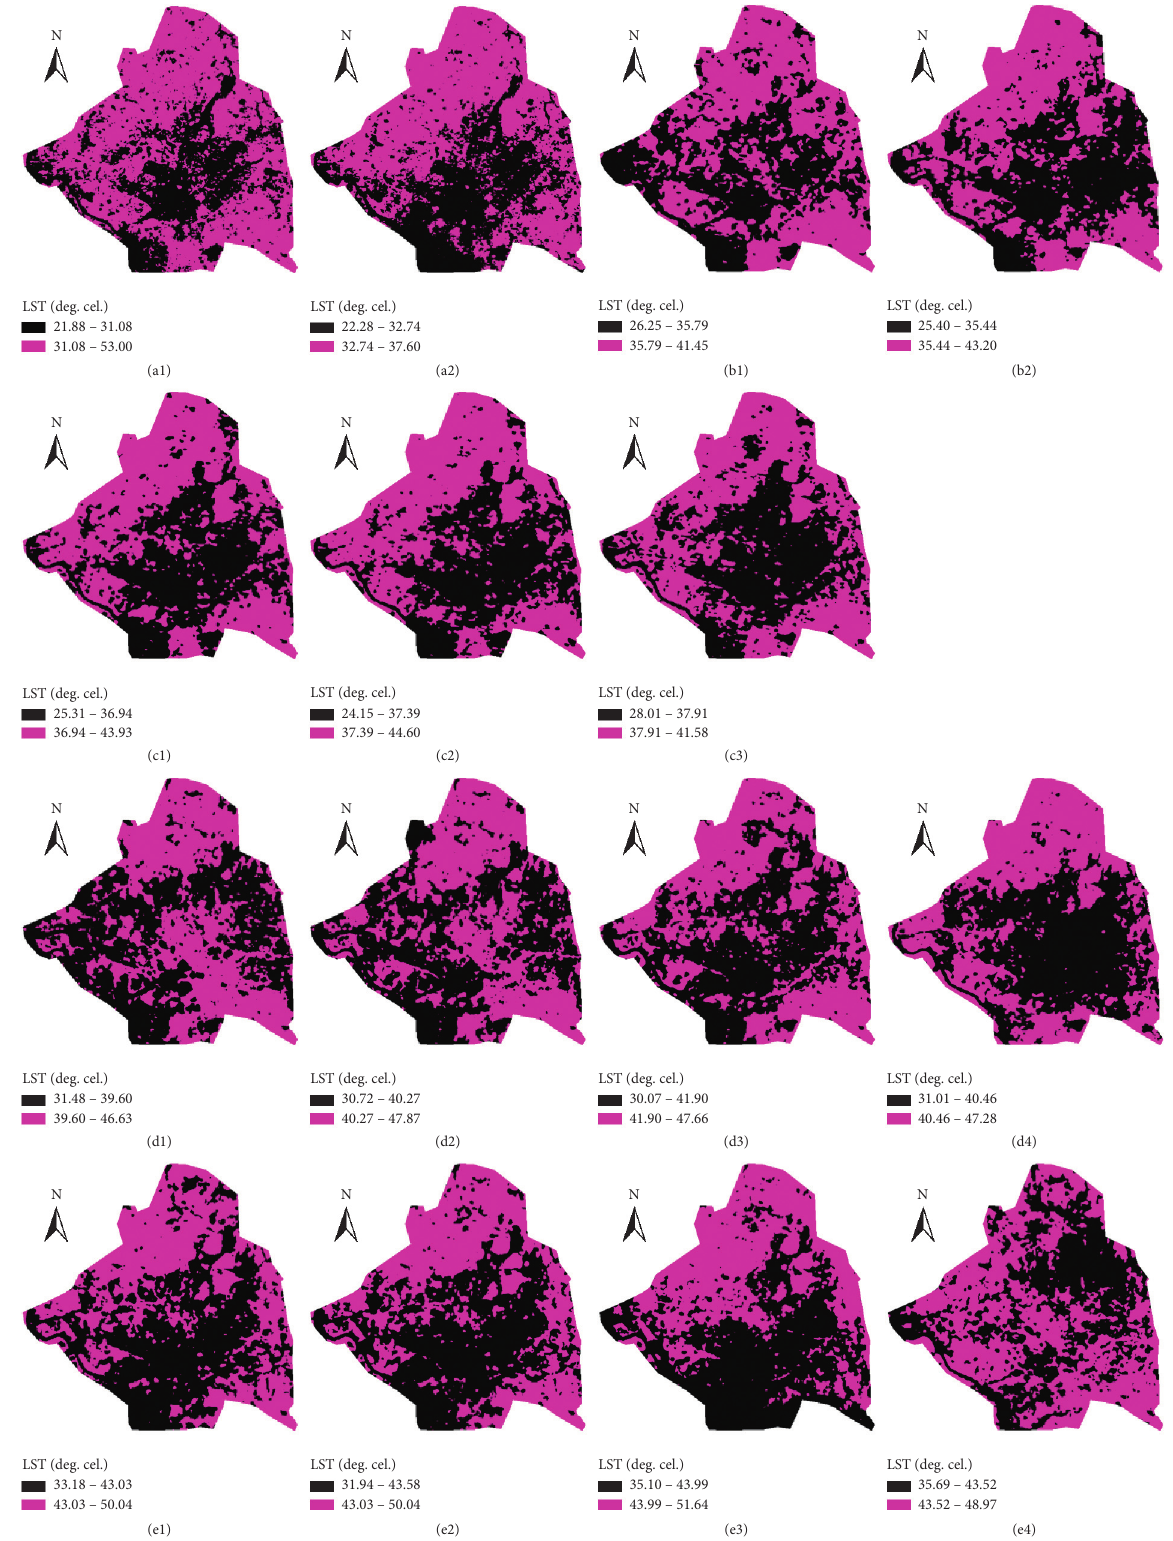
Figure 6: The area above mean LST (pink portion) and the area below mean LST (black portion): (a1-a2) 2002, (b1-b2) 2006, (c1–c3) 2010, (d1–d4) 2014, and (e1–e4)